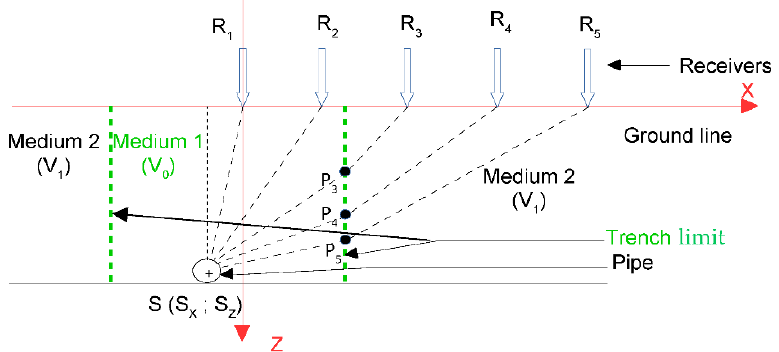
Figure 15. Scheme of the problem modeling in the case of two propagation media: Model M2.